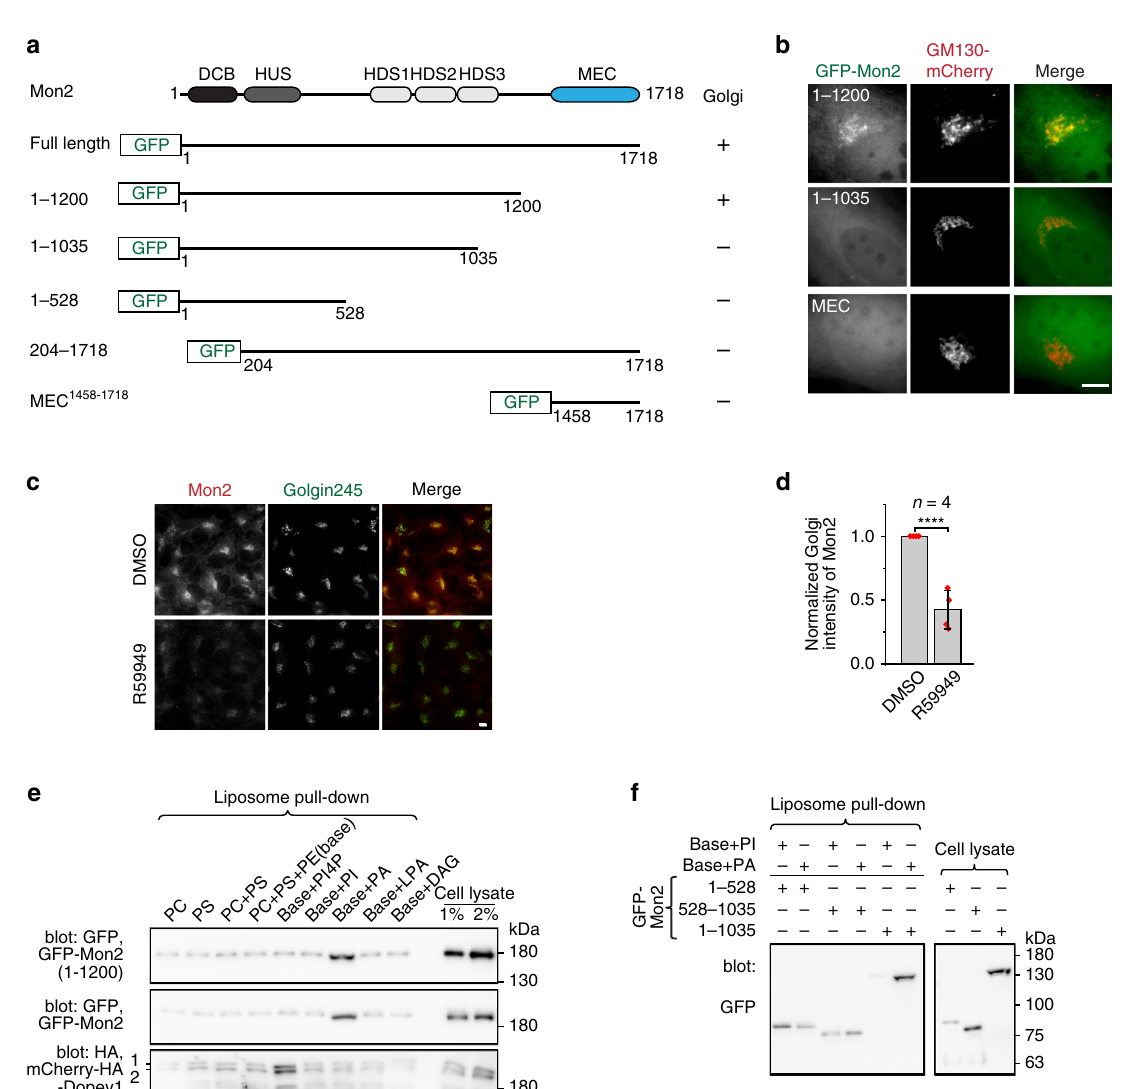
Fig. 4 The Golgi localization of Mon2 requires its binding to PA. a , b The region comprising residues 1 – 1200 is necessary and suf fi cient for the Golgi localization of Mon2. Schematic diagrams of GFP-tagged Mon2 truncations are shown in ( a ). The Golgi localization is scored based on fl uorescence staining experiment in ( b ), in which cells co-expressing selected Mon2 truncations and GM130-mCherry (a Golgi marker) were imaged live. c R59949 reduces the Golgi localization of Mon2. Cells were treated with DMSO (control) or 1 µ M R59949 for 1 h followed by co-staining of endogenous Mon2 and Golgin245. Normalized Golgi intensity of Mon2 is plotted in ( d ). Red dot, individual data point; error bar, mean ± s.d. from four independent experiments. P values are from t test (unpaired and two-tailed); **** P ≤ 0.00005. e , f Mon2 speci fi cally interacts with PA. The liposome pull-down experiments were similar to Fig. 3i – l except that liposomes with indicated phosphoglycerides were used. 1 and 2 indicate full length and a possibly degraded product of Dopey1 fusion protein. Molecular weights (in kDa) are labeled in gel blots. Scale bar, 10 µ m. HeLa cells were used in ( b , c ), while HEK293T cell lysates were used in ( e , f ). Source data are provided as a Source Data fi